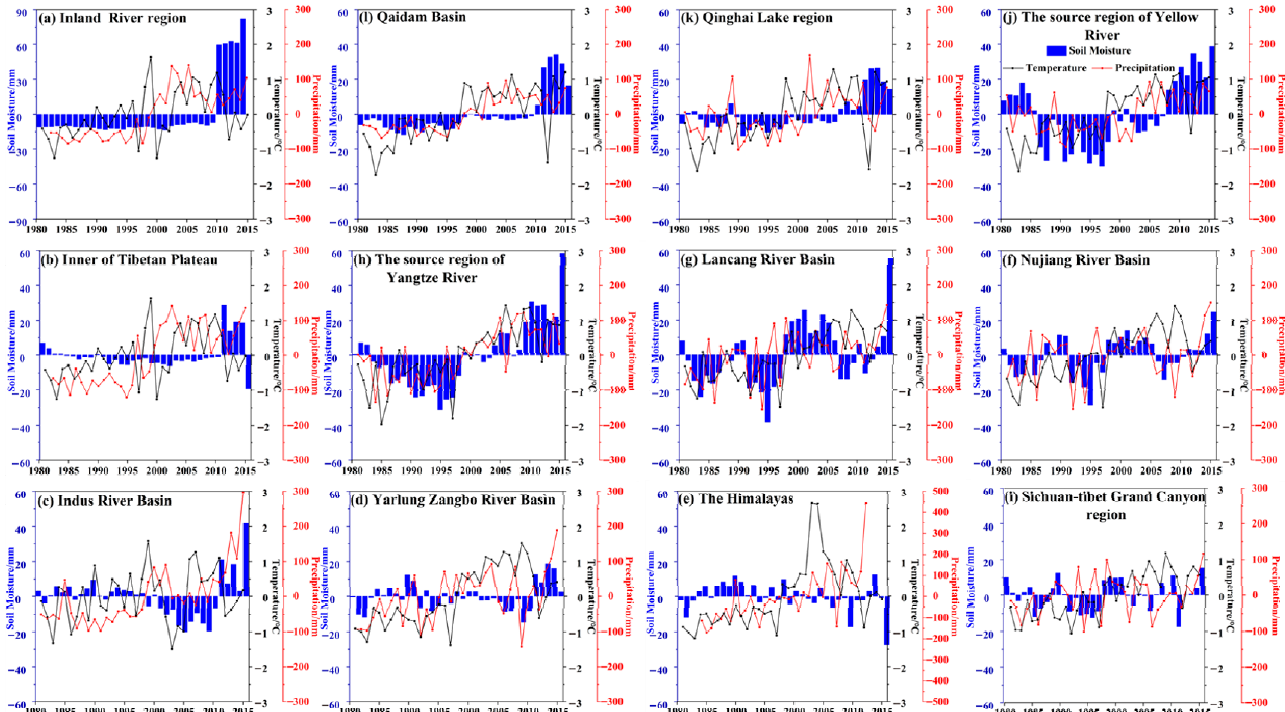
Figure 11. The annual temperature, precipitation, and soil moisture anomalies for each sub-region over the Tibetan Plateau during the period 1981–2015.